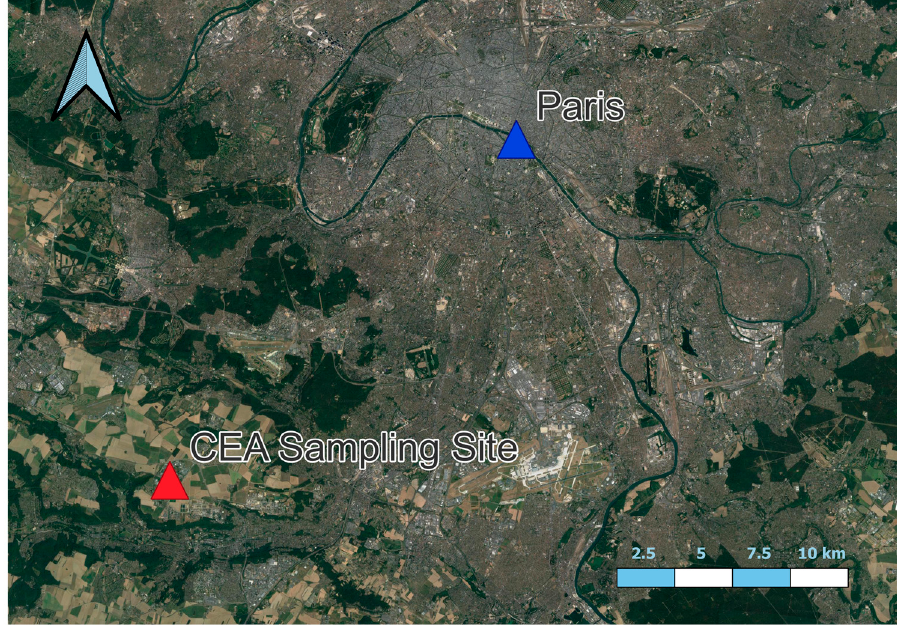
Figure 1. Site of the Bio detect 2 sampling campaign (Illustrating the proximity to the centre of Paris).